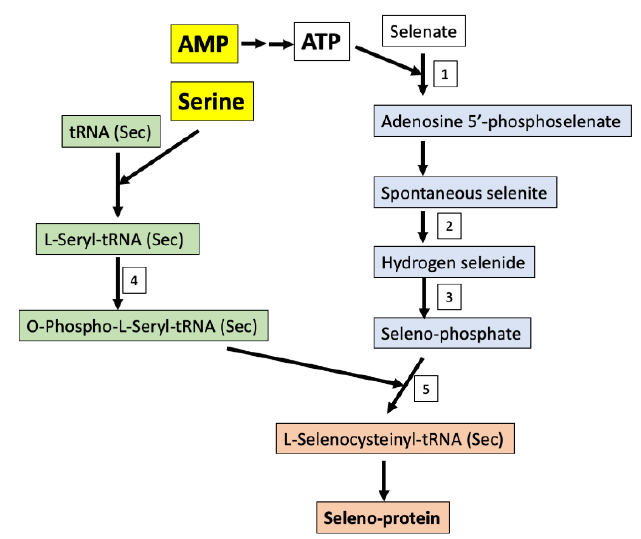
Figure 4. Seleno-protein synthesis in humans using organic or inorganic sources of selenium from the diet. Enzymes: 1-Sulfate adenylyltransferase; 2-NADPH (reduced nicotinamide adenine dinucleotide phosphate)-thioredoxin reductase; 3-Selenophosphate synthase; 4- O -phosphoseryl-tRNA(Sec) kinase; 5- L -selenocysteinyl-tRNA(Sec) synthase and O -phosphoseryl-tRNA: Selenocysteinyl-tRNA synthase.